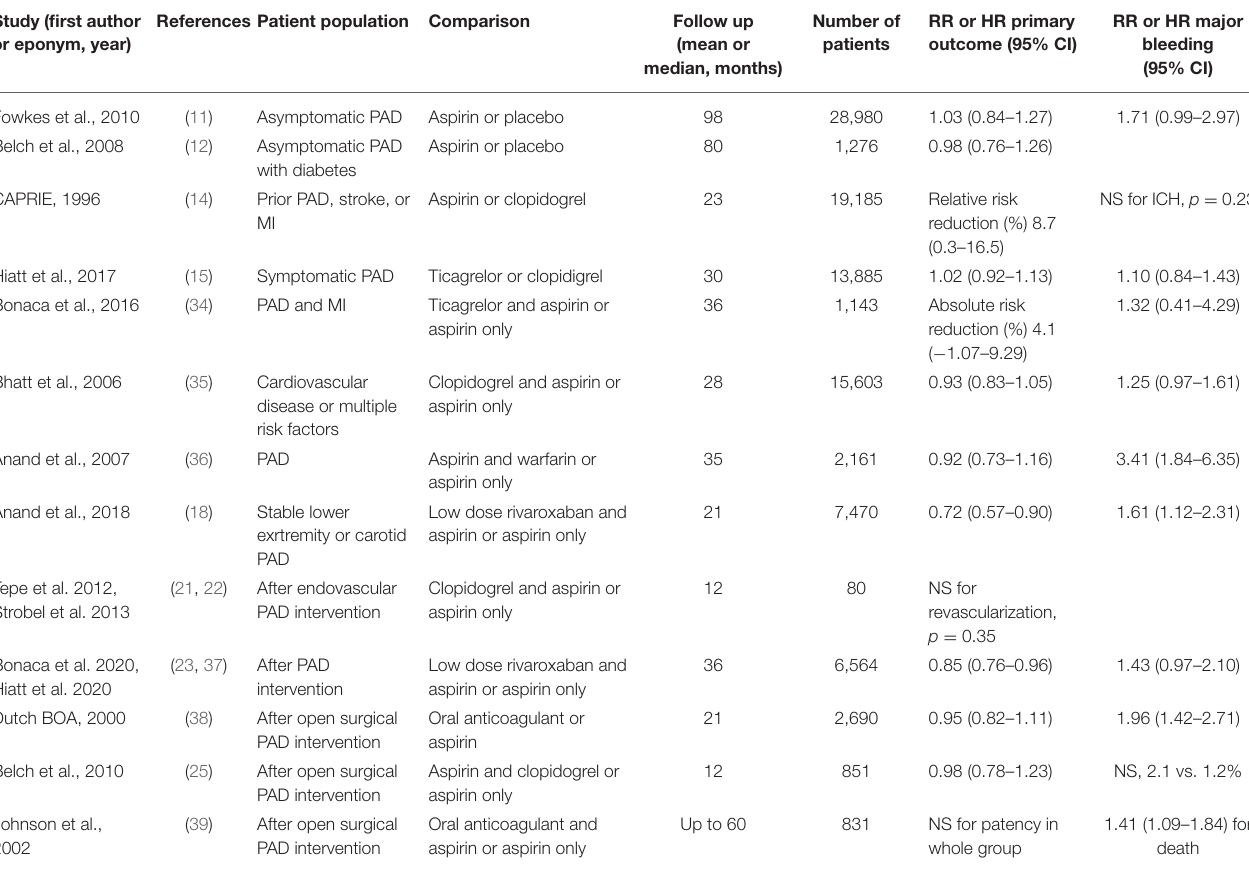
TABLE 2 | Studies of antithrombotic therapy in peripheral arterial disease